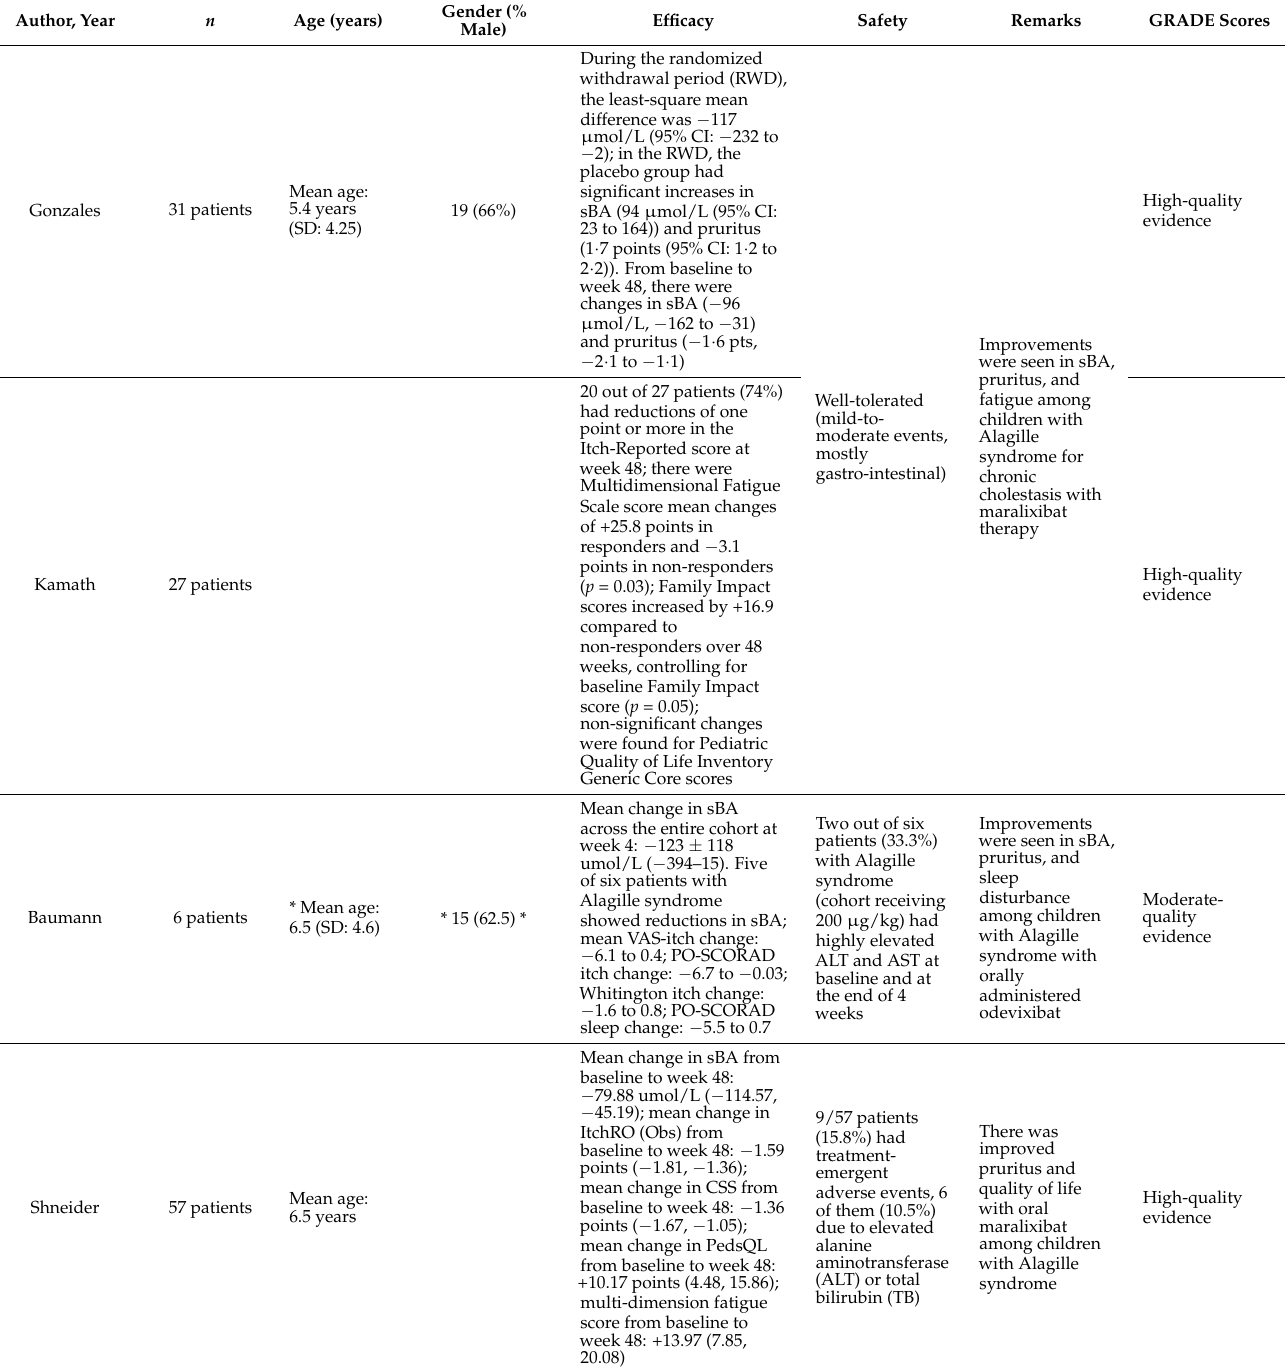
Table 3. Patient characteristics, outcomes of the studies, and GRADE quality assessment